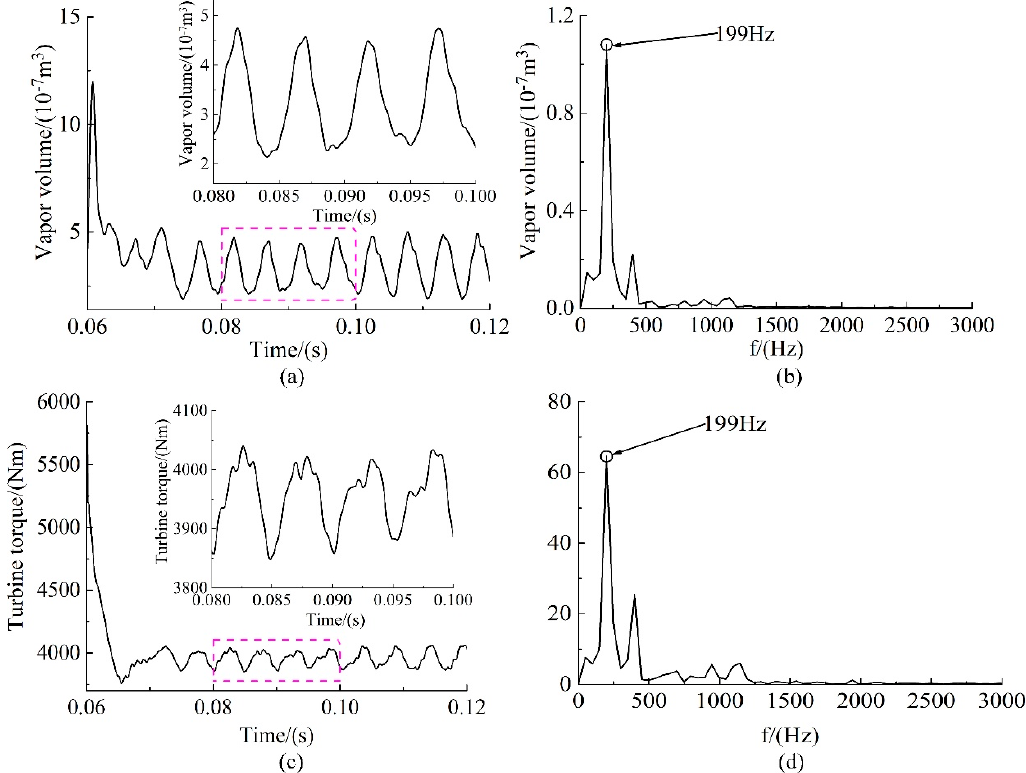
Figure 15. Variations in the vapor volume and torque of the turbine in the time and frequency domains ( SR = 0): ( a ) vapor volume, ( b ) vapor volume spectrum, ( c ) torque, and ( d ) torque spectrum.